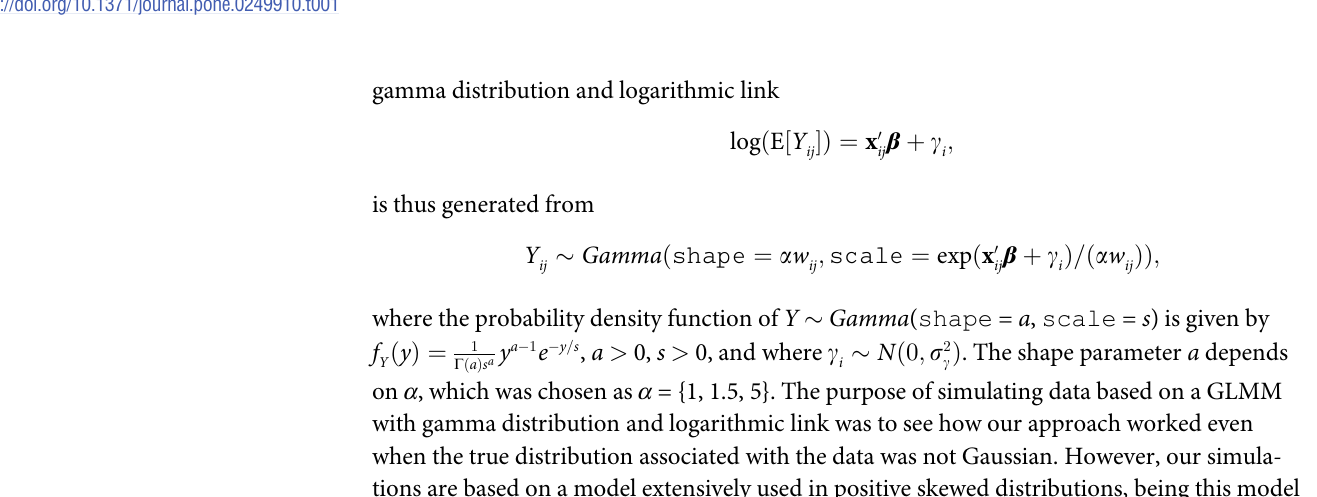
Table 1. Summary of the MSE for different values of m , n i , σ 2 , and s 2